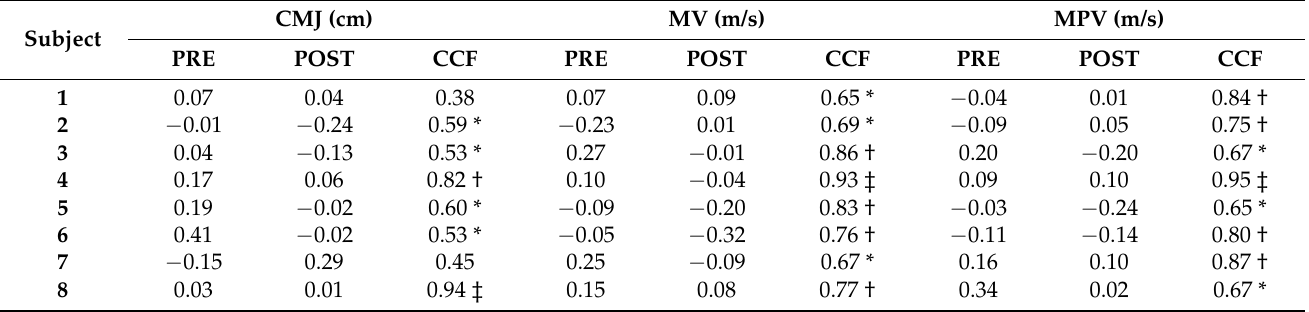
Table 3. Results of the temporal series for each and all players using the autocorrelation function for each variable and cross correlation function relating to pre- and